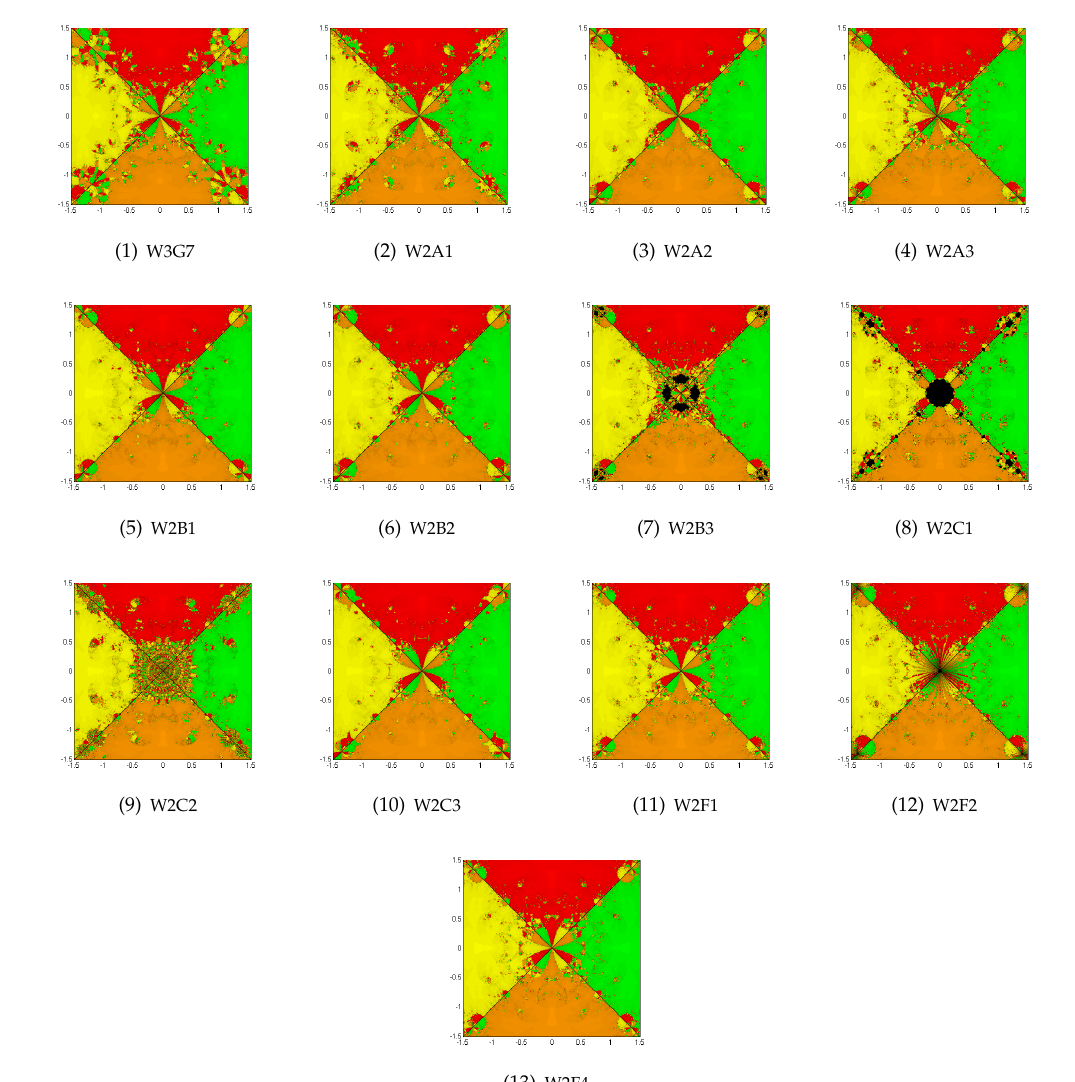
Figure 6. The top row for W3G7 ( left ), W2A1 ( center left ), W2A2 ( center right ) and W2A3 ( right ). The second row for W2B1 ( left ), W2B2 ( center left ), W2B3 ( center right ) and W2C1 ( right ). The third row for W2C2 ( left ), W2C3 ( center left ), W2F1 ( center right ) and W2F2 ( right ). The bottom row for W2F4 ( center ), for the roots of the polynomial equation ( z 4 − 1 ) 3